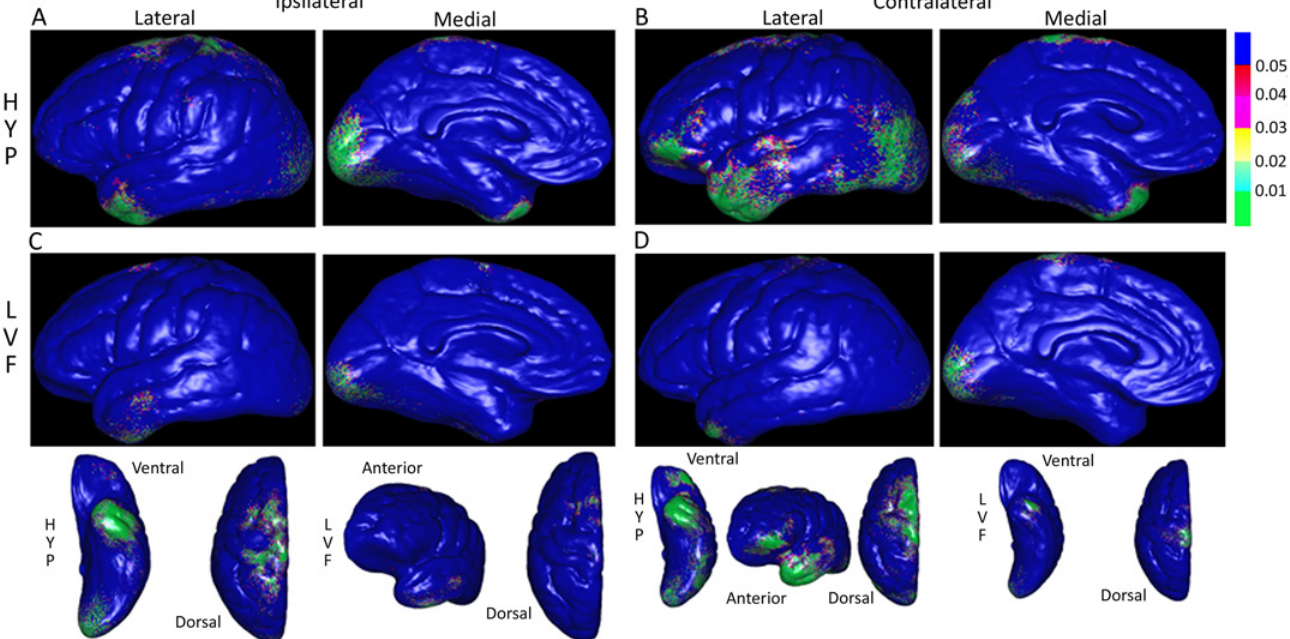
Fig 3. Color-coded probability or P-maps depicting the spatial pattern of significantly reduced gray matter thickness in patients with respect to controls. Lateral and medial views of cerebral hemisphere ipsilateral (A & C) and contralateral (B & D) to the SOZ in patients with hypersynchronous (HYP, top row) versus patients with low voltage fast (LVF, bottom row) onset seizures. P-maps in bottom row are the same as in rows above, but reoriented to more clearly show gray matter thickness changes on ventral, dorsal, and anterior aspects. In upper right, P-values scaled such that areas shaded green correspond to P < 0.01 and blue P > 0.05 (not